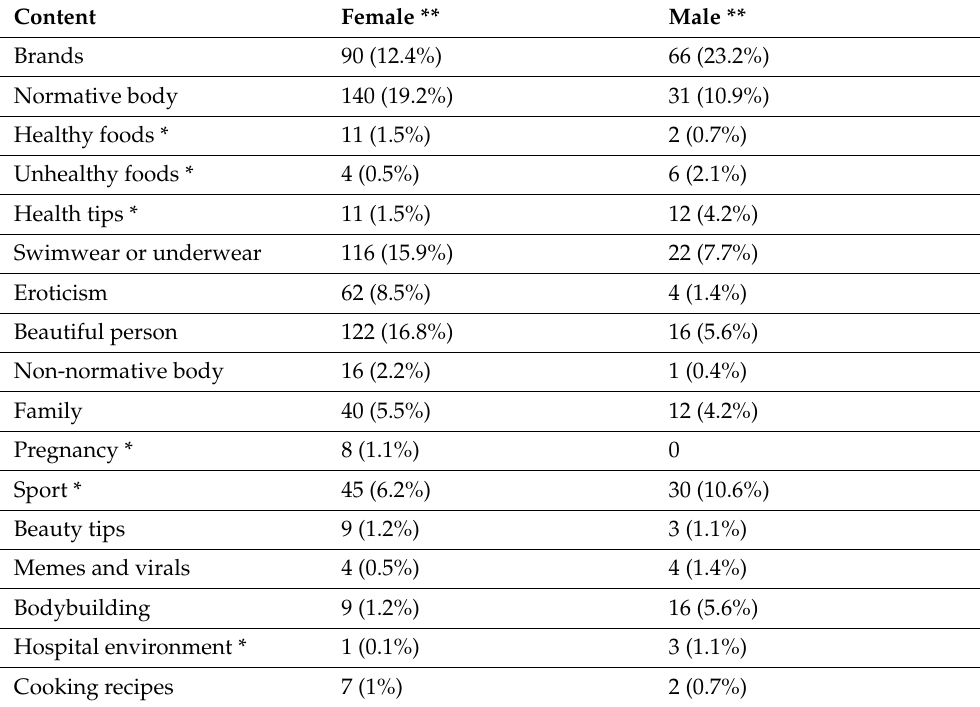
Table 4. Type of content published based on the influencer’s gender. Source: own elaboration.